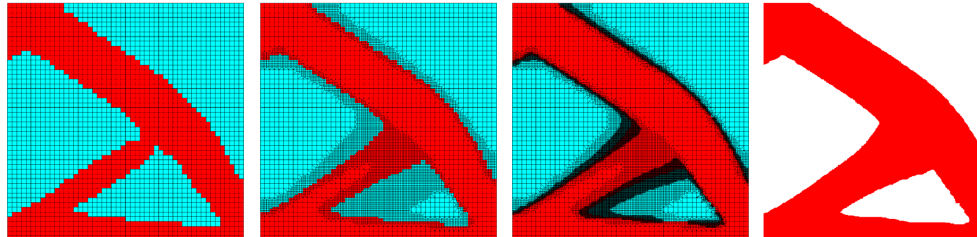
Figure 9. Selected middle topologies and the final one for the introductory example—for the last iteration, the grid has not been shown, to improve the clarity of the